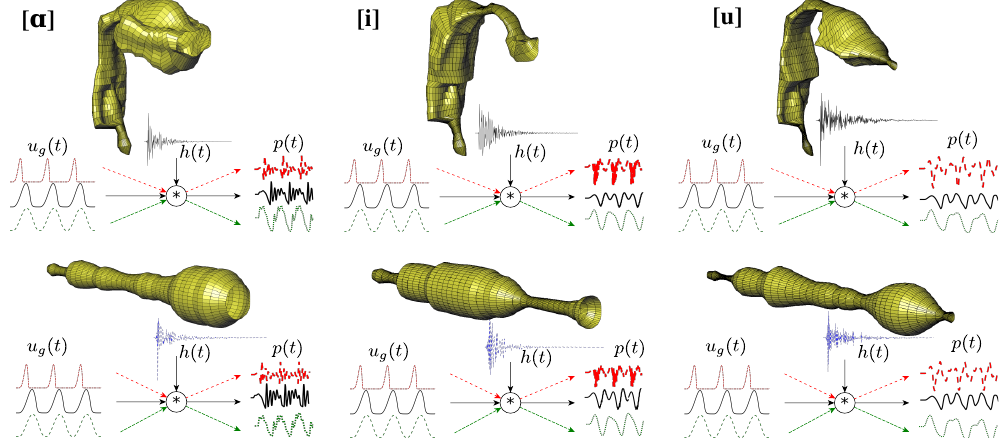
Figure 1. Synthesis of vowels [ A ], [i], and [u] with realistic vocal tract geometries (above) and their simplified counterparts of circular cross-sections set in a straightened midline (below). The output pressure signal p ( t ) is computed as the convolution of the glottal source u g ( t ) with the vocal tract impulse response h ( t ) obtained from a 3D FEM (finite element method) simulation. Three phonation type examples are represented in the figure: Tense (dashed red line), modal (solid black line), and lax (dotted green